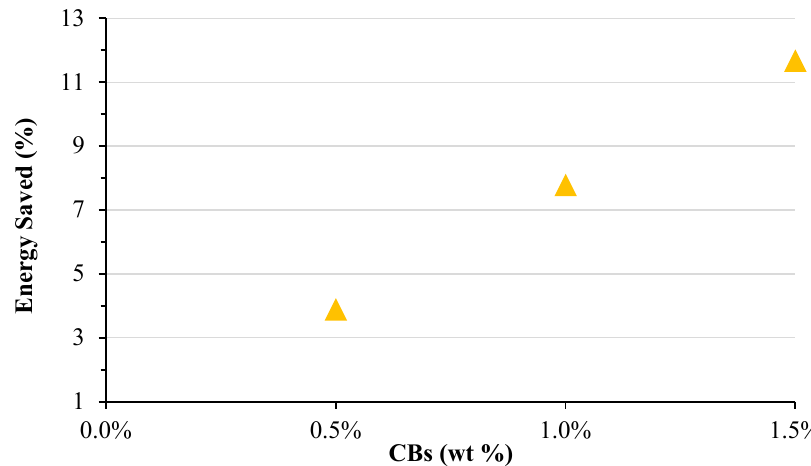
Figure 9. Calculated energy savings versus CB% by mass.